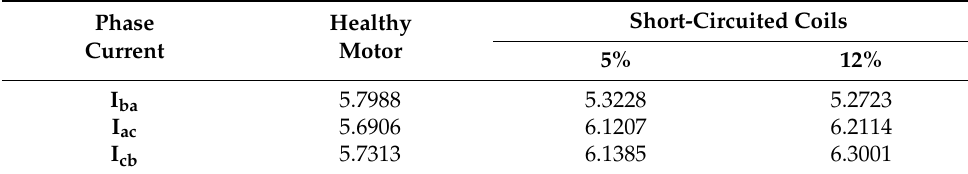
Table 2. RMS value of line currents.